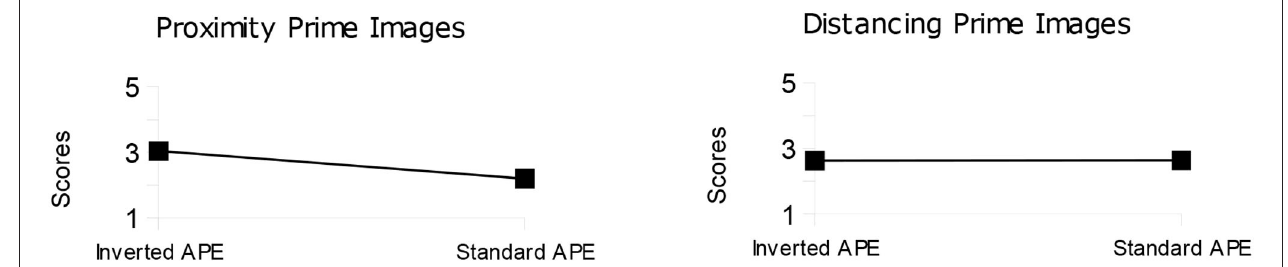
FIGURE 3 | Mean scores for proximity (leftward panel) and distancing (rightward panel) prime images from participants showing the inverted and standard APE. Scores range from 1 (definitely positive) to 5 (definitely negative).